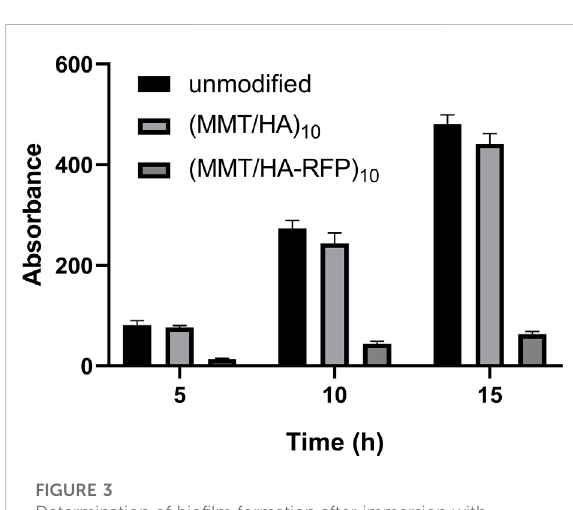
FIGURE 3 Determination of bio fi lm formation after immersion